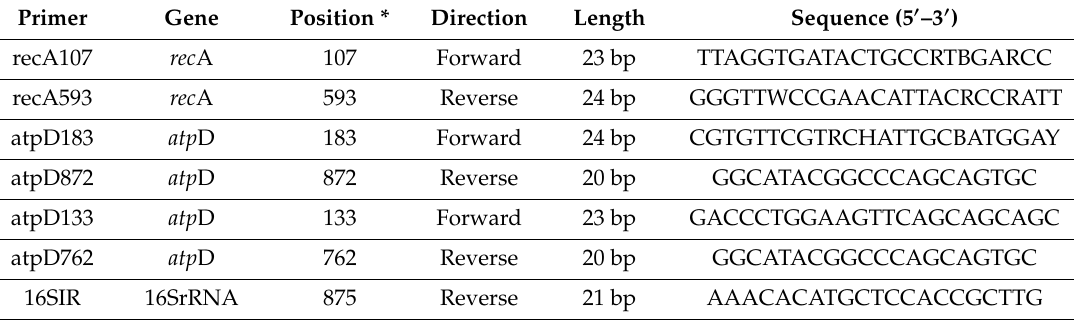
Table 1. Newly designed primers for PCR and